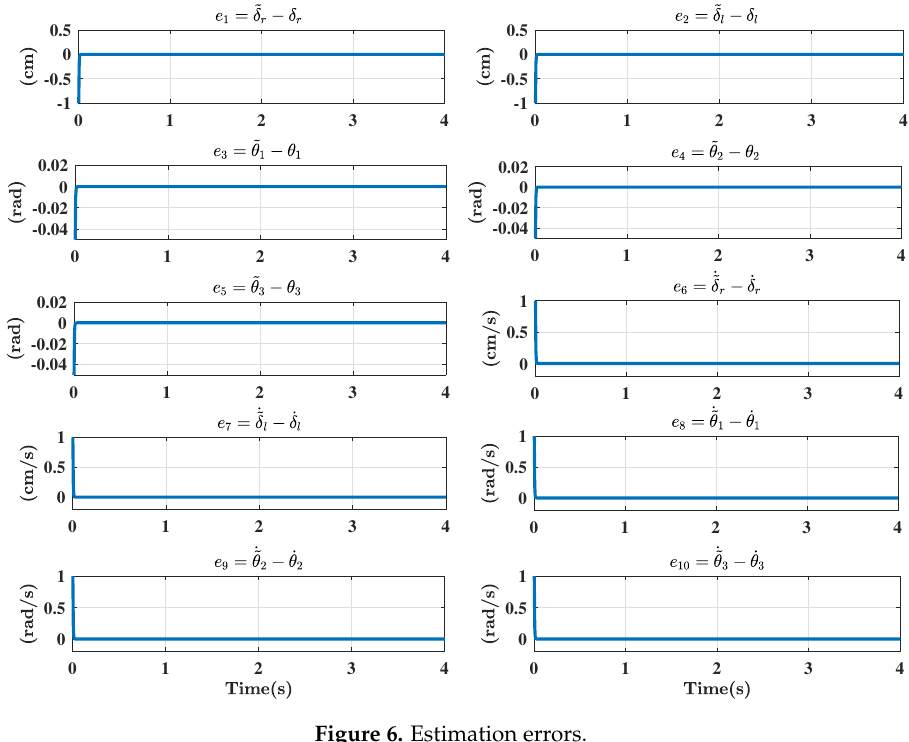
Figure 6. Estimation errors.